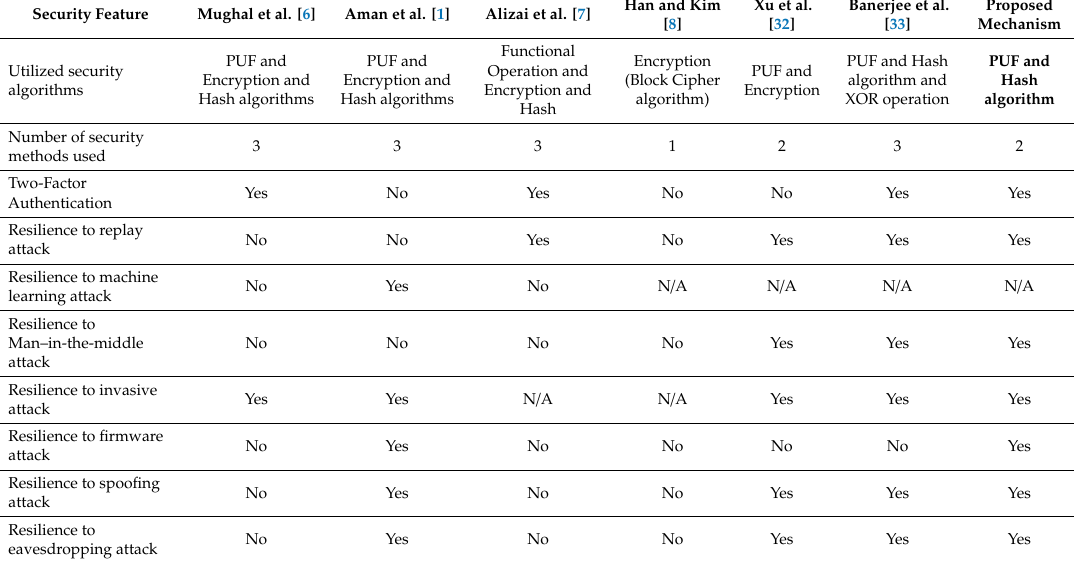
Table 3. Comparison of the cyber defense capabilities of our proposed mutual authentication mechanism and the most recent PUF-based mutual authentication